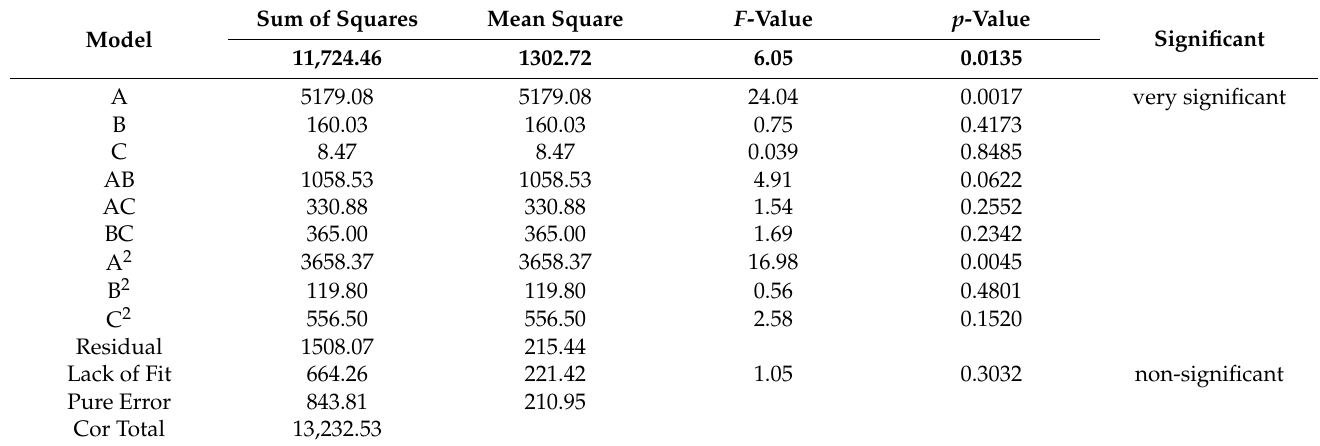
Figure 2. Effect of type and concentration of cross-linking agent, cross-linking temperature, and cross-linking time on immobilized lipase-specific activities. ( A ) Glutaraldehyde, poly (ethylene glycol) diglycidyl ether, and ethylene glycol diglycidyl ether were investigated. The control group was only treated with adsorption. ( B ) Cross-linking agent is glutaraldehyde. ( C ) Cross-linking agent is glutaraldehyde and enzymatic reaction temperature is 30 °C. The means value of three replicates ±SD is represented. Table 1. ANOVA and fit statistics of the quadratic model for immobilization